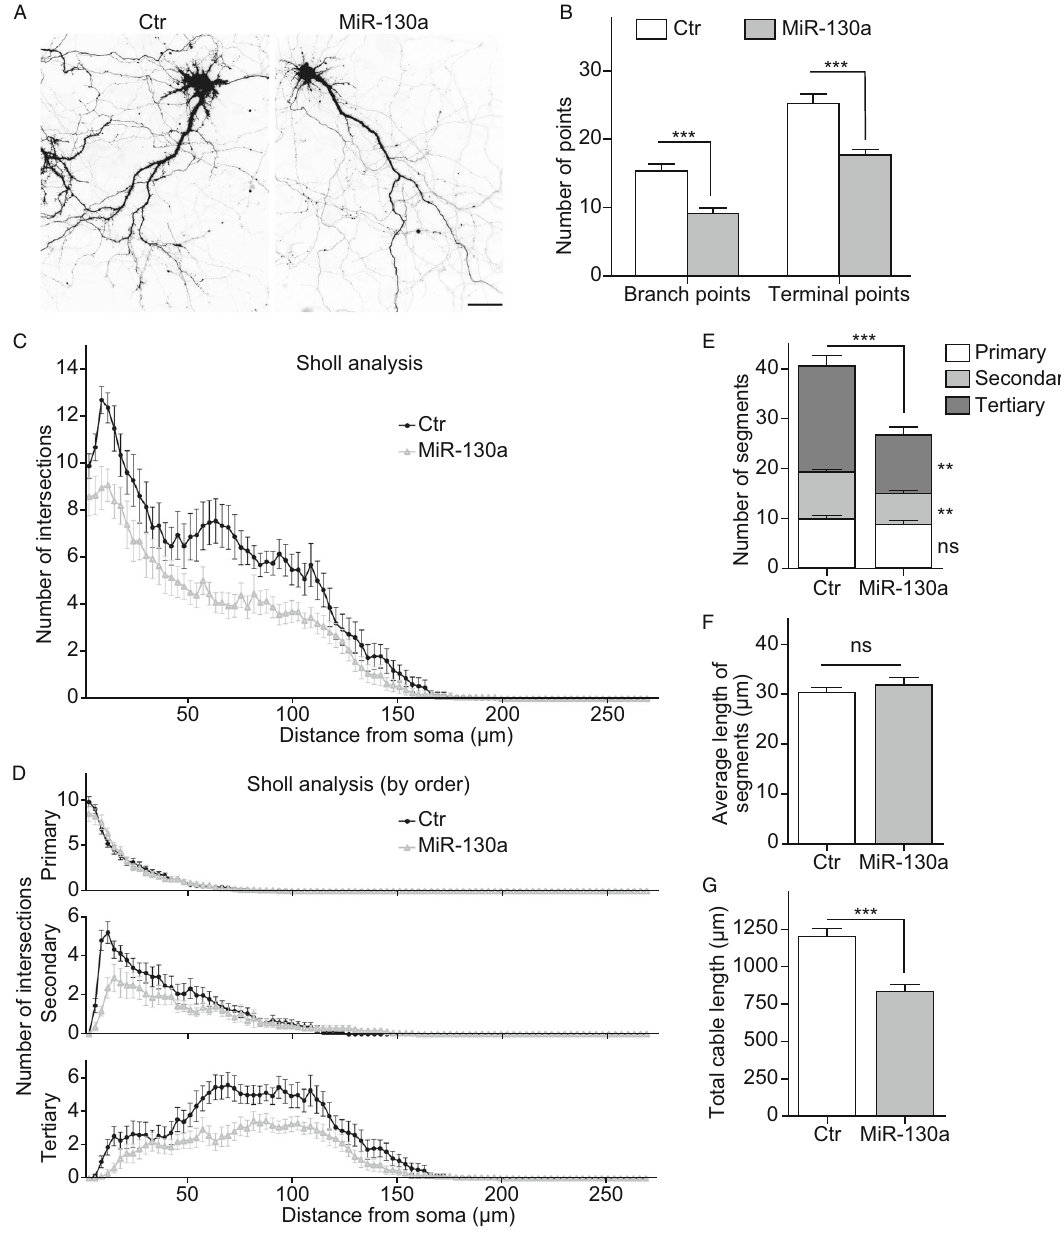
Figure 3. MiR-130a decreases the complexity of dendrites. (A) Cortical neurons were cultured for 7 days and transfected with control or miR-130a. Cells were fi xed at 18 DIV. Images were taken using Leica confocal SP8. Image of 40× microscopy were demonstrated. Scale bar: 25 μ m. (B) The number of branch points and terminal points per cell. (C) The Sholl analysis of dendritic complexity as measured by number of intersections. (D) The Sholl analysis of dendritic complexity by branch order-primary, secondary and tertiary branches. (E) The number of segments in total and by branch order. (F) Average length of segments per cell. (G) The total length of branches per cell. **, P < 0.01; ***, P < 0.001, Mann-Whitney test. Fifteen neurons were scored in each group in each experiment. The bar diagram represents mean values ± SEM. Data represent 3 independent